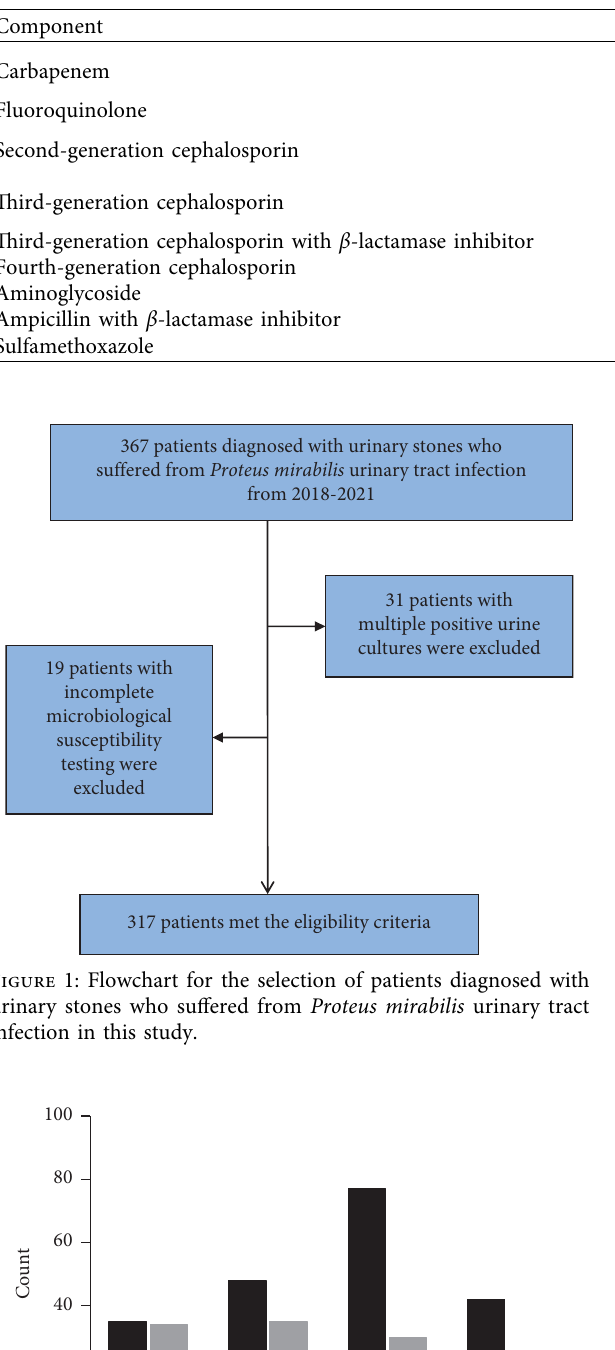
Table 1: Antibiotic agents used for determination of the susceptibility pattern of Proteus mirabilis .